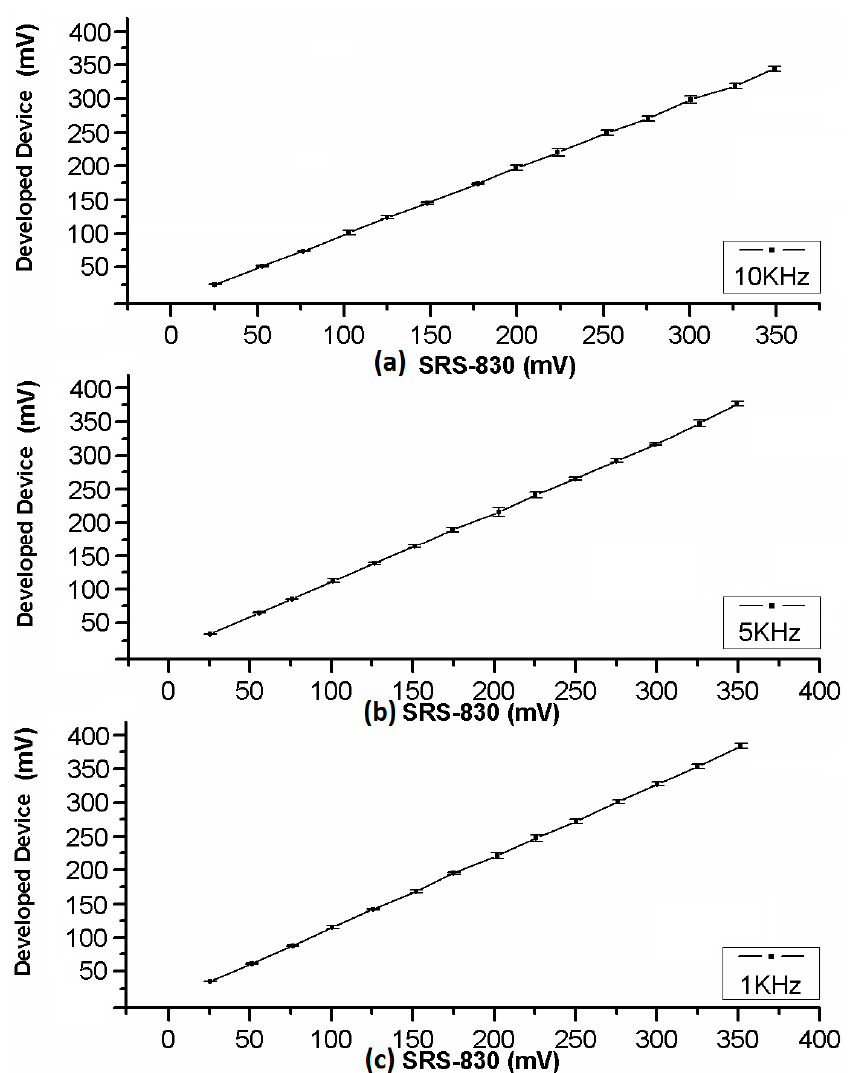
Figure 5. Amplitude detection response of the proposal versus SR830 LIA at different frequencies: ( a ) 10 kHz; ( b ) 5 kHz; and ( c ) 1 kHz.